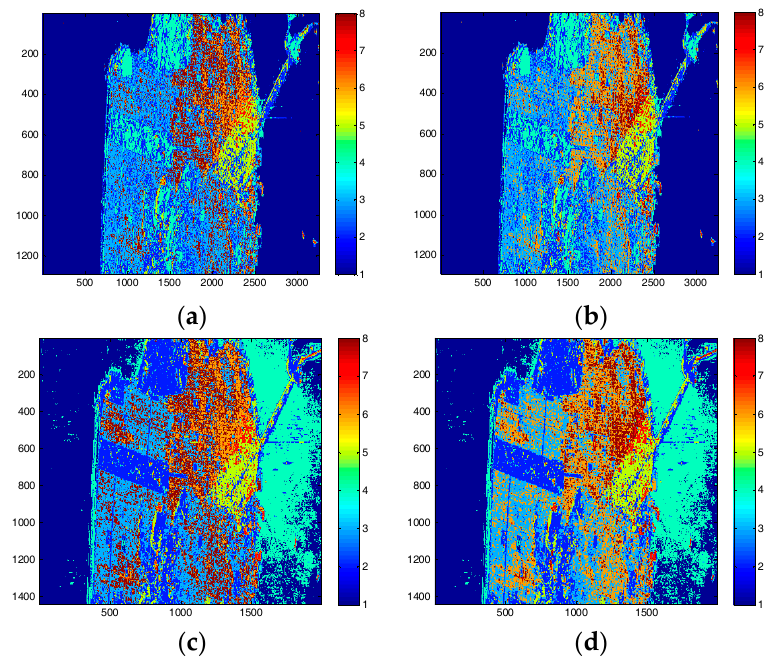
Figure 5. The Wishart classifier results initialized by the H / alpha plane are shown in ( a , c ), and results initialized by the ∆ α B / α B diagram are shown in ( b , d ). ( a , b ) are results of the GF-3 data, and ( c , d ) are results of the Radarsat-2 data.